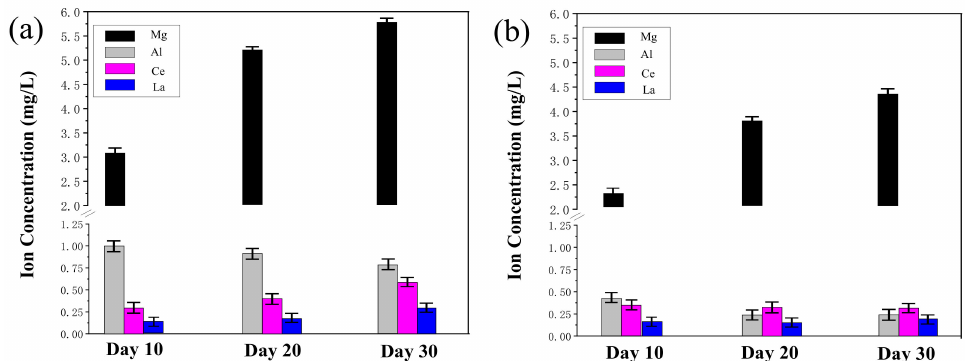
Figure 9. Metallic ion concentrations of the PBS solution at 310 K with ( a ) Mg-RE alloy ingot sample and ( b ) sheet with TRC sample at day 10, day 20 and day 30 under immersion